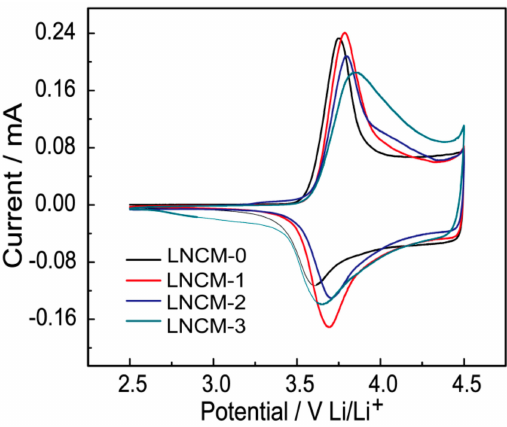
Figure 5. Cyclic voltammetry (CV) curves of LNCM-0~LNCM-3 cathodes at a scan rate of 0.1 mV s − 1